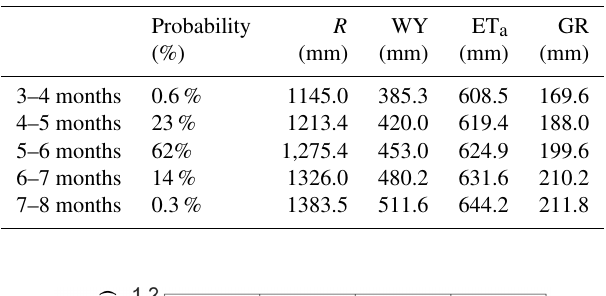
Table 5. Water balance components associated to occurrence prob- abilities for each duration of the rainy period.